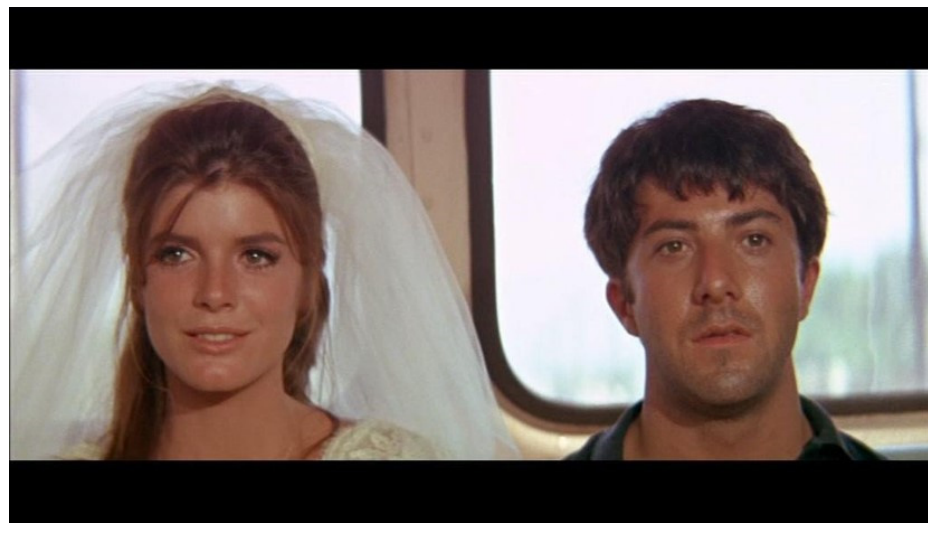
Figure 1. Awkward silence permeates the ending of The Graduate (1967).